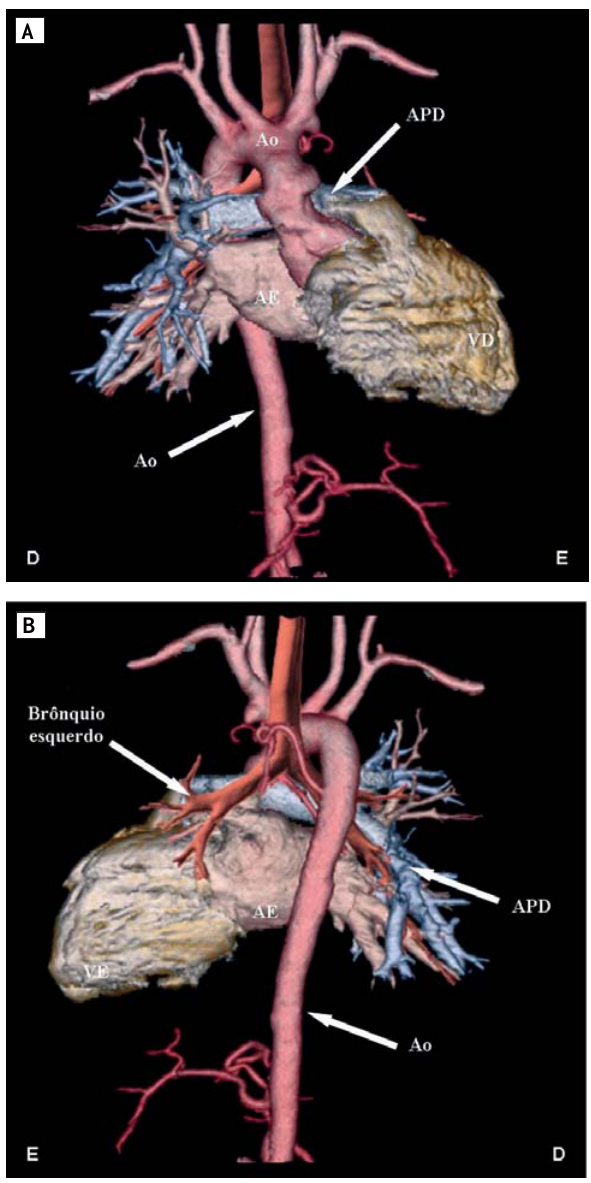
Fig. 2 – A: Tomografia computadorizada de múltiplos detectores em vista anterior demonstrando com clareza a agenesia da artéria pulmonar esquerda. B: Vista posterior com a aorta descendente